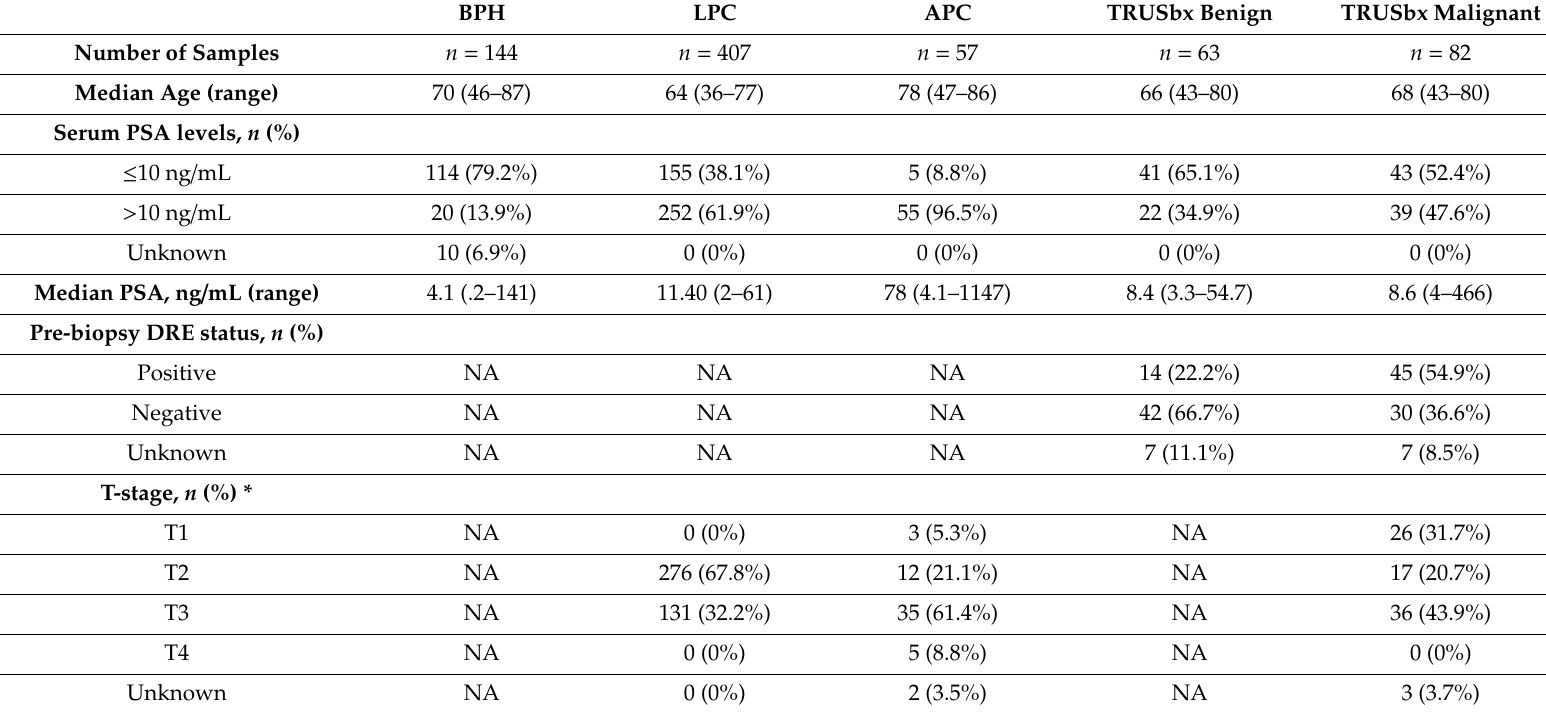
Table 1. Summary of clinicopathological characteristics of patient